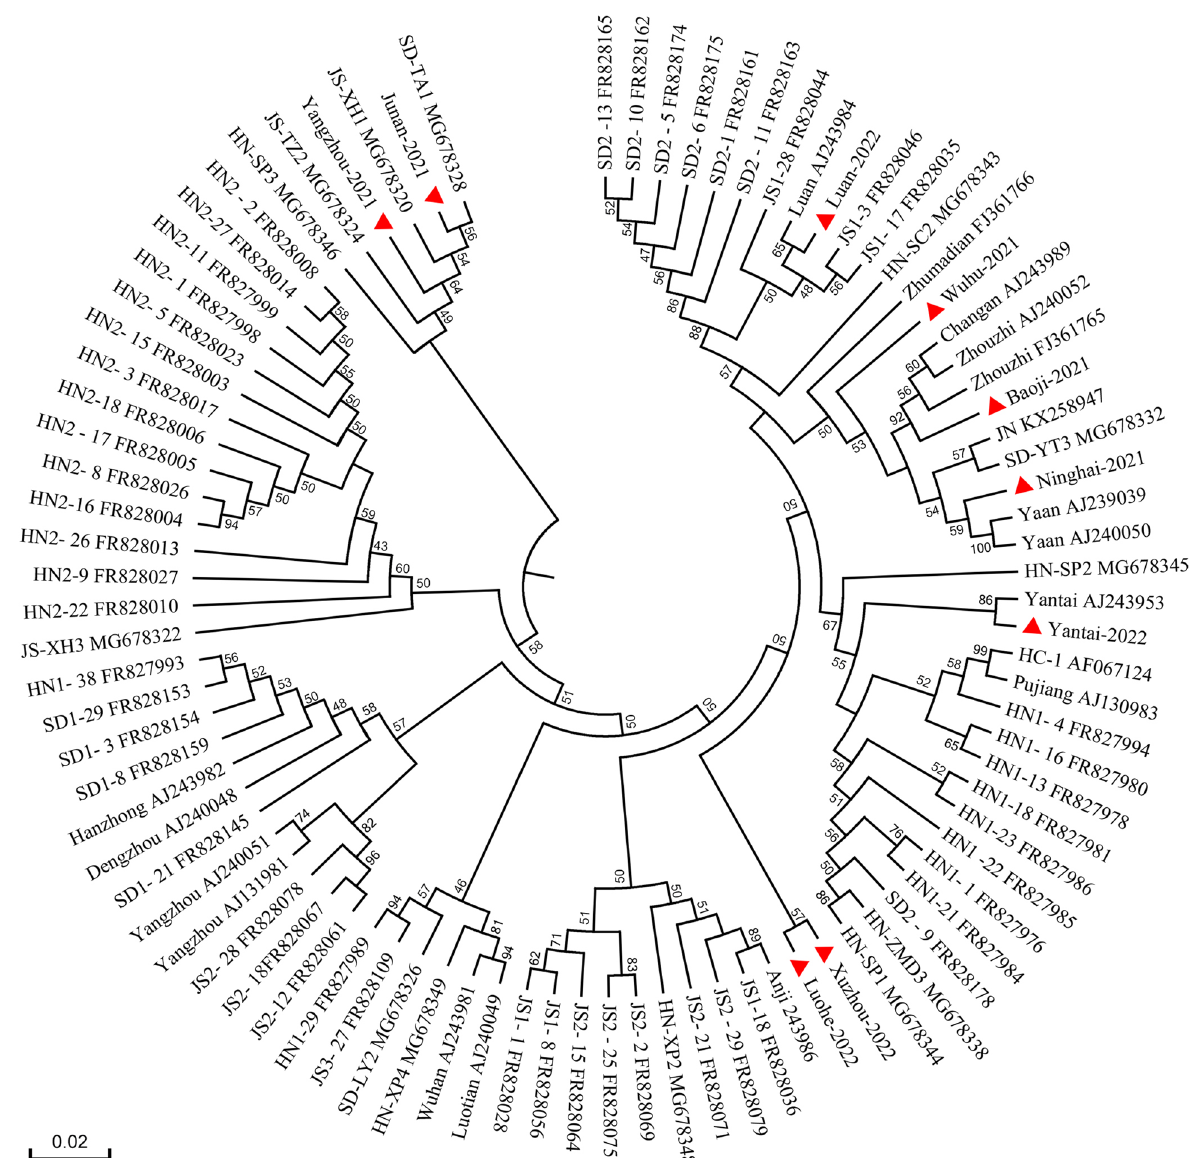
Fig. 2 Maximum likelihood phylogenetic analysis of 90 wheat yellow mosaic virus coat protein (CP)-encoding nucleotide sequences. Branches are labeled with the provenance of the sequence from this study and GenBank accession numbers. Sampling sites on the branches were represent for the location in China. Names of each of 9 isolates obtained in this study are preceded by a red triangle. Numbers at branches represent bootstrap values of 1000 replicates. Only bootstrap values 40% are ≥